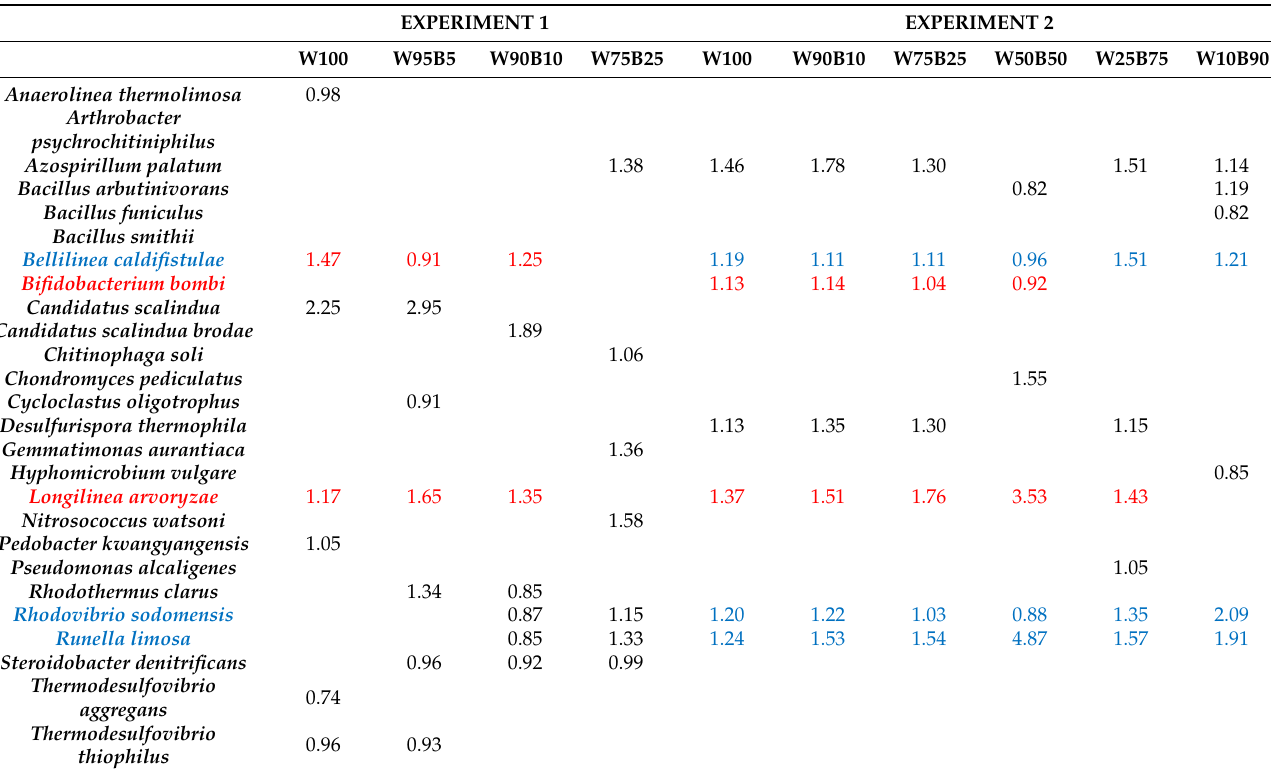
Table 5. Species classification for worm castings (W) blended with biochar (B) by percent of total nucleic acids in the sample